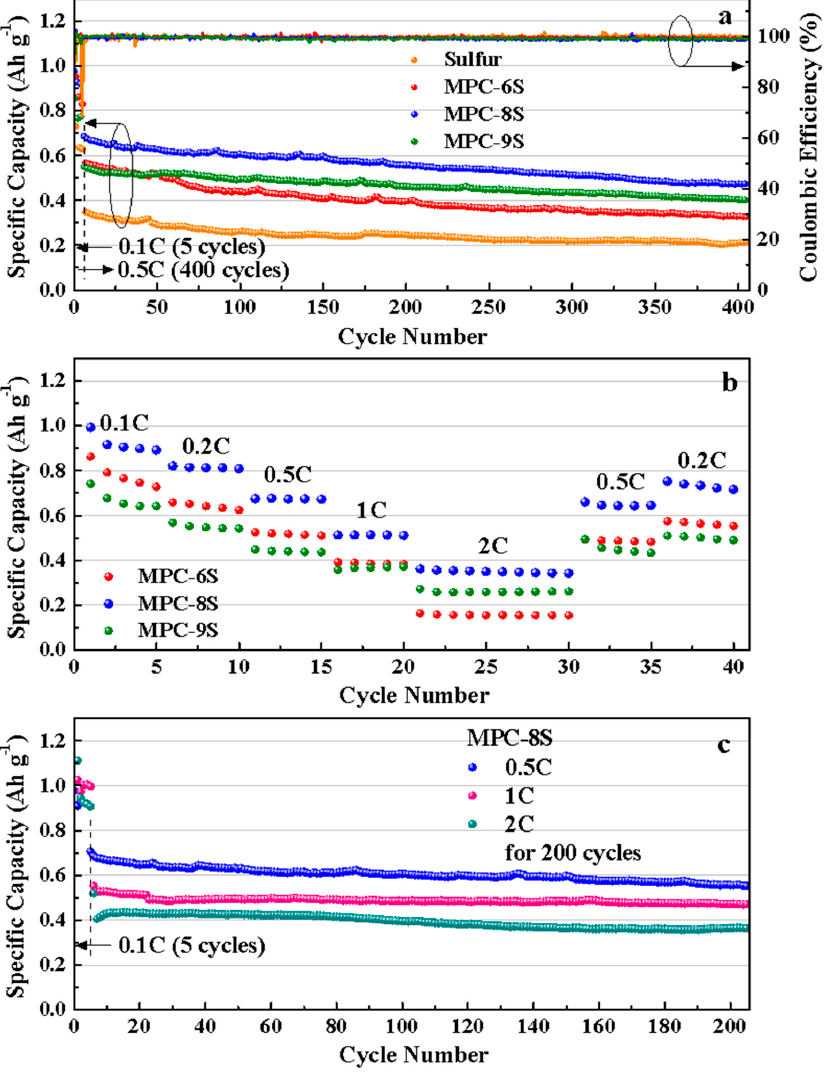
Figure 8. ( a ) Cycling performance and ( b ) Rate capability of the MPC-6S, MPC-8S, and MPC-9S cells. ( c ) Cycling performance of the MPC-8S at 0.5C, 1C, 2C for 200 cycles.